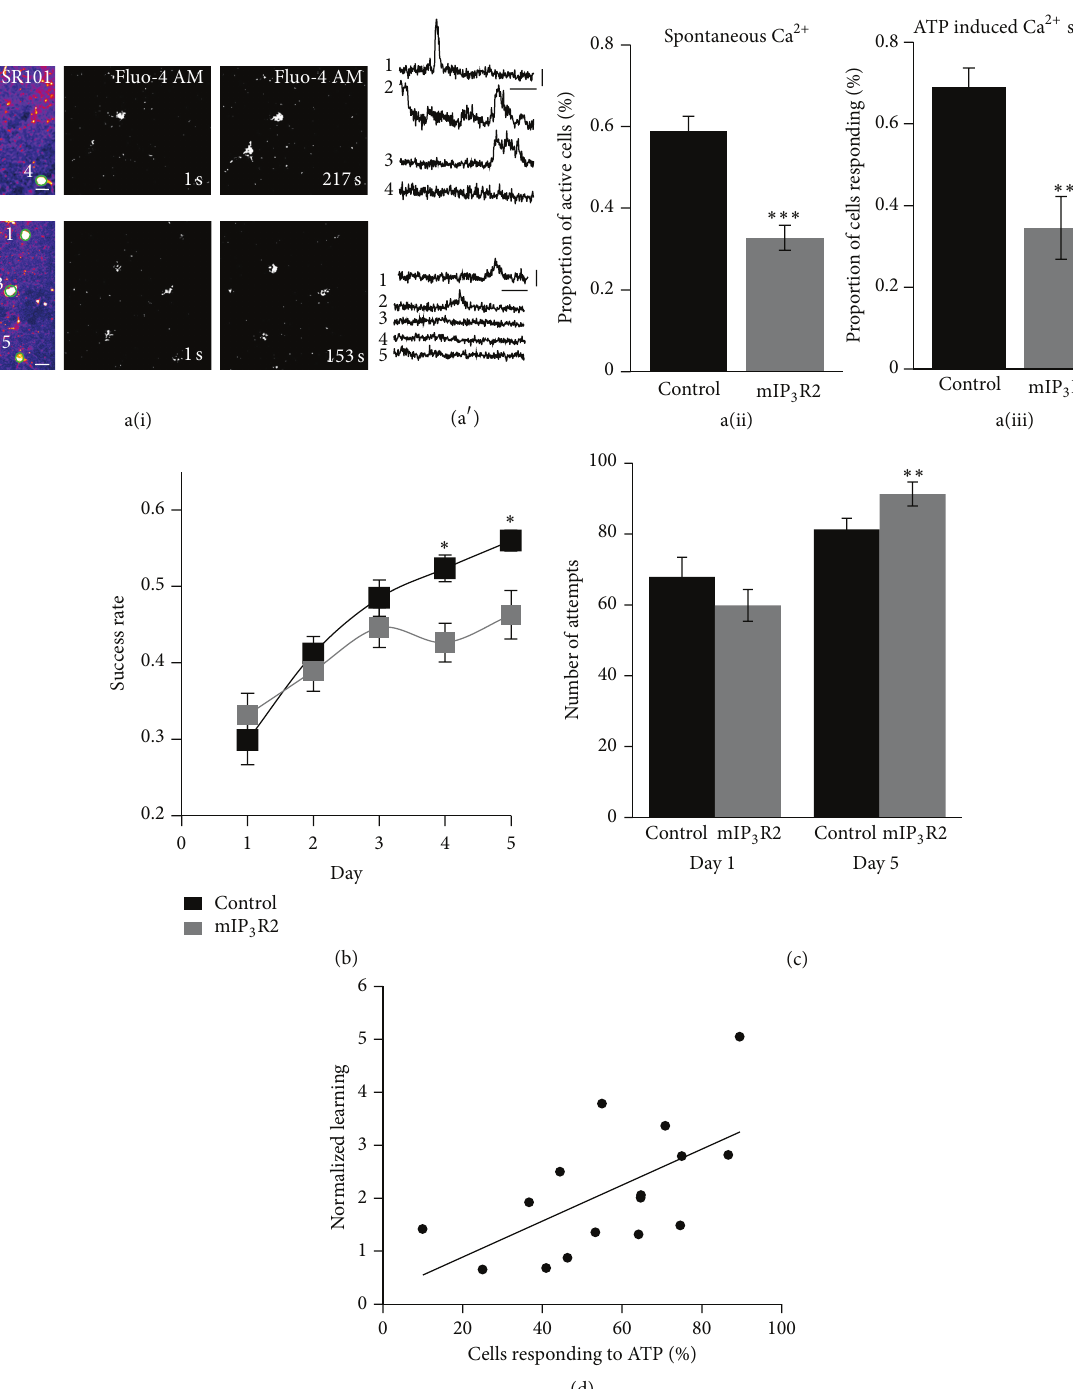
Figure 1: IP 3 R2 mediated Ca 2+ signaling is necessary for motor-skill learning. a(i) Dual loading of acute M1 slices with SR101 (left) and fluo-4 AM (right) in control (top panel) and mIP 3 R2 (bottom panel) mice. ROIs of astrocyte soma are outlined and numbered. Time-lapse images of the fluo-4 channel for control and mIP 3 R2 KO mice showing spontaneous Ca 2+ transients in soma. Scale bar: 10 𝜇 m. (a 󸀠 ) Spontaneous Ca 2+ transients in soma in control and mIP 3 R2 mice. Scale bar: 50 s, 100% Δ𝐹/𝐹 . a(ii) Quantification of the proportion of active cells with spontaneousCa 2+ transientsinsomaincontrolandmIP 3 R2slices.a(iii)QuantificationofATP-inducedCa 2+ transientsincontrolandmIP 3 R2 slices. (b) Motor-skill learning curves for control and mIP 3 R2 mice. mIP 3 R2 mice show a deficit in motor-skill learning. Repeated measures two-way ANOVA revealed a significant interaction between genotype and training factors ( 𝑃 = 0.0055 ). (c) Number of reaching attempts made on day 1 and day 5 in control and mIP 3 R2 mice. (d) Relationship between ATP-induced Ca 2+ transients and learning (success rate on day 4/success rate on day 1). ∗ 𝑃 < 0.05 , ∗∗ 𝑃 < 0.01 , and ∗∗∗ 𝑃 < 0.0001